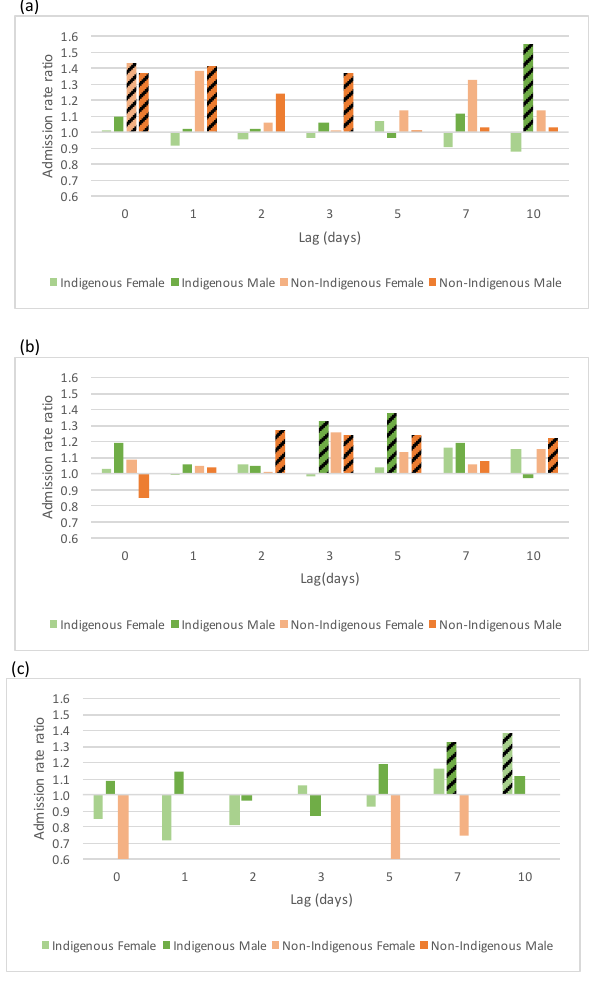
Figure 4. Selected cold effects on acute respiratory admissions, expressed as rate ratios, by Indigenous status and sex over lags of 0 to 10 days. ( a ) Cold effects, defined by Tmin, on residents aged 0–9 in the Top End climate zone; ( b ) cold effects, defined by Tmax, on residents aged 35+ in the Top End climate zone; ( c ) cold effects, defined by Tmin, on residents aged 0–9 in the Central Australia climate zone. Effects that are statistically significant at the five per cent significance level are highlighted with a diagonal